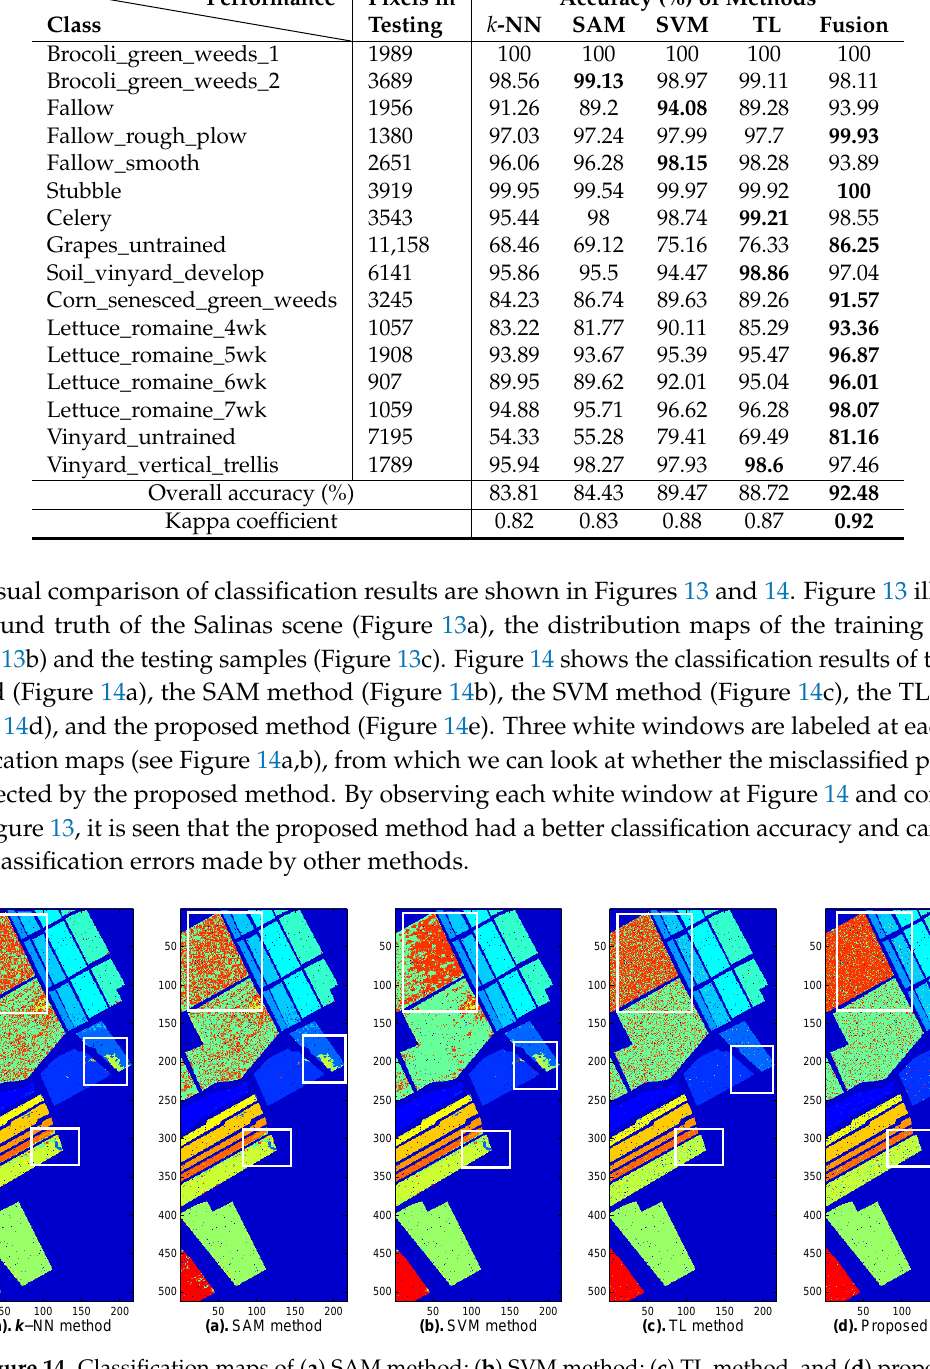
Table 6. Performance comparison, AVIRIS Salinas dataset, 16 classes, 1% training samples. Class